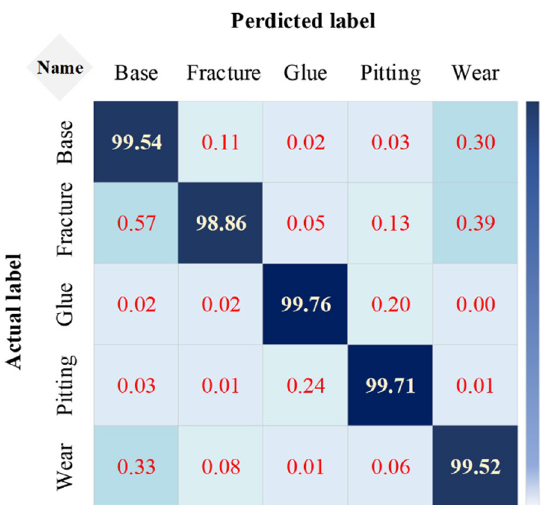
Fig. 12 Confusion matrix of defect classification. Each row represents the distribution of predicted labels of points corresponding to each actual label. The depth of the color in the graph represents the predicted percentage